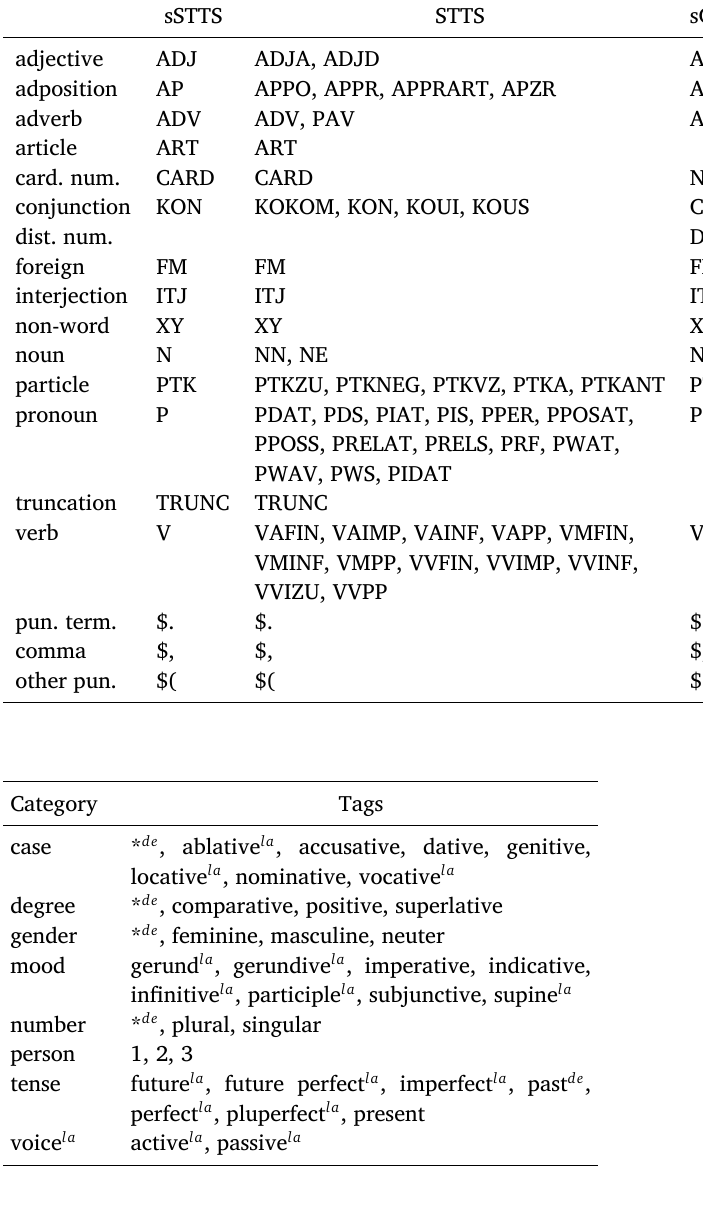
Table 6: Mapping simplified tagsets for STTS and CHSTS sSTTS STTS sCHSTS